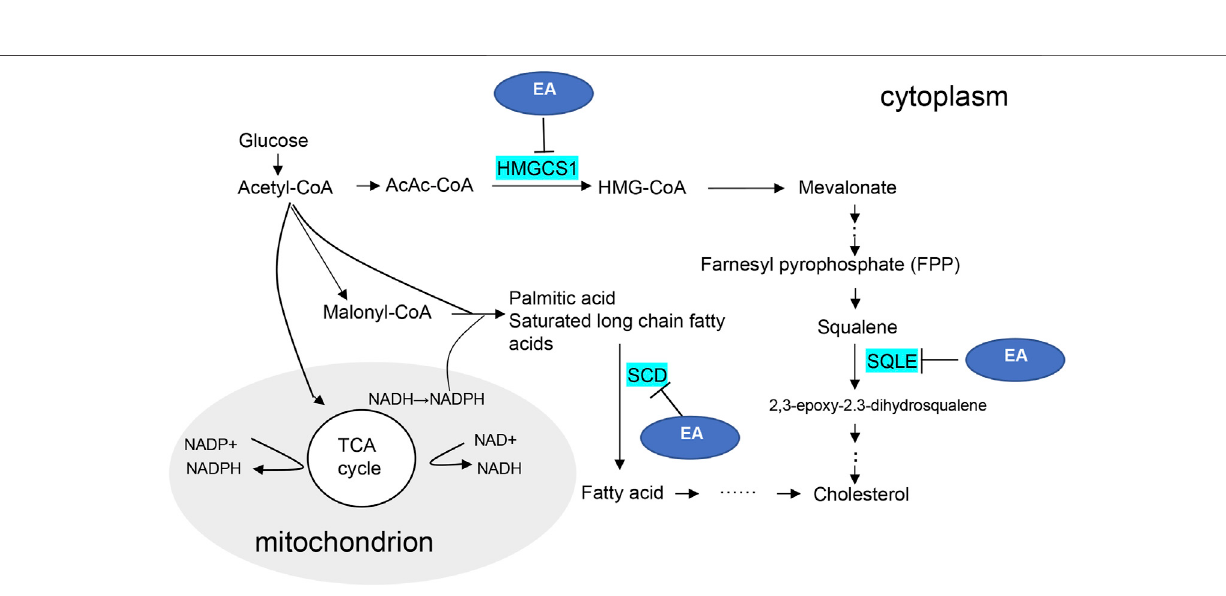
Frontiers in Pharmacology |